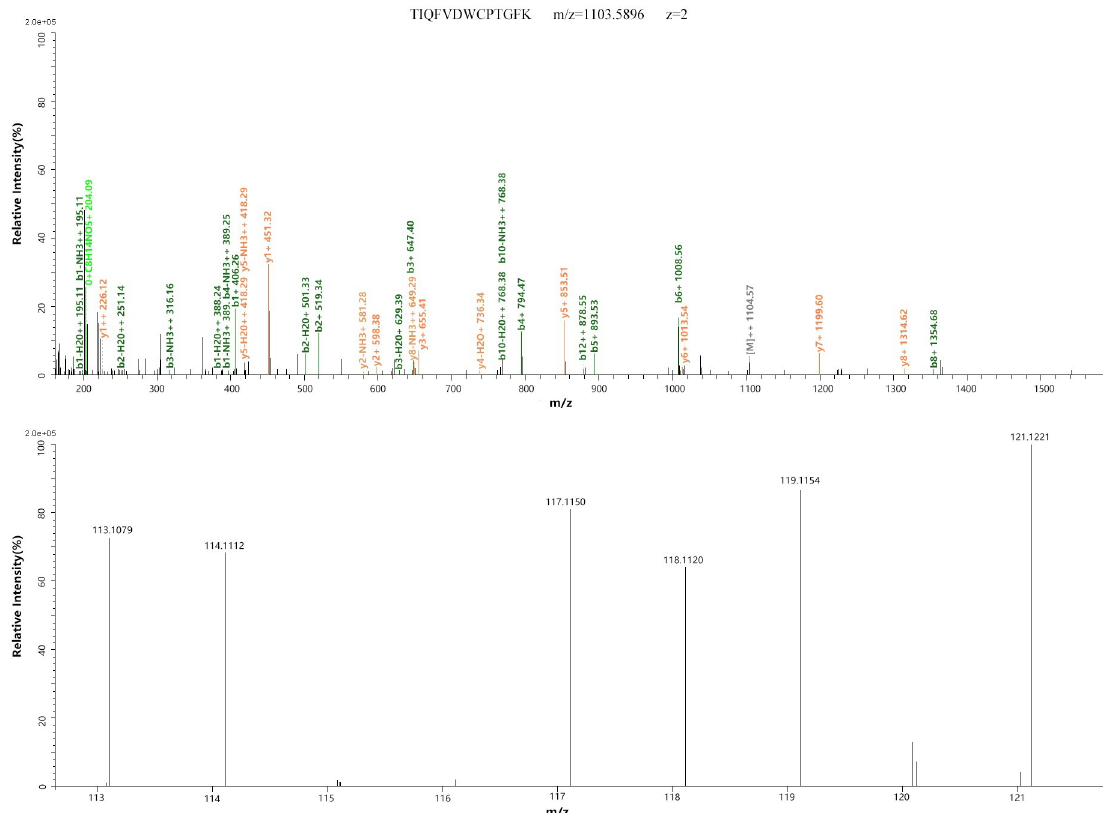
Fig 2. MS/MS spectra of TUBA1A. MS/MS spectra used for the identification and quantitation of TUBA1A with 113, 114 and 117 tags for CIH samples, and 118, 119 and 121 tags for control samples. Top, the MS/MS spectra of precursor ion TIQFVDWCPTGFK for identifying TUBA1A. Bottom, relative quantitation of